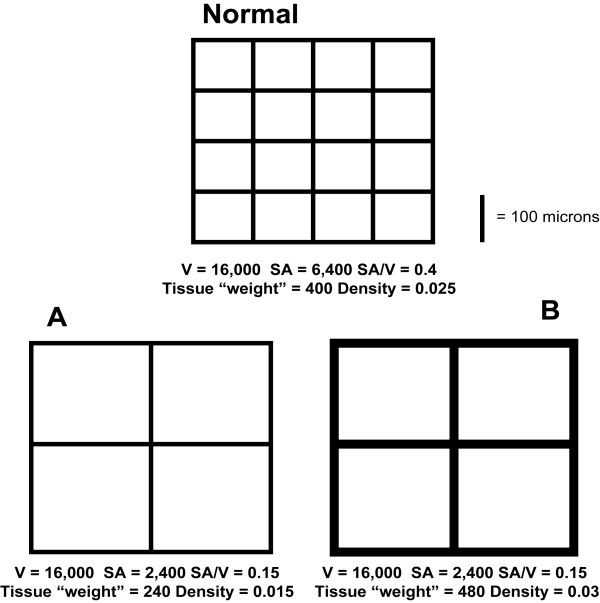
A Schematic Showing the Relationship between Lung SA/V and Density under two scenarios. The top panel represents normal lung architecture with the dimensions of each "alveolus" being 100 × 100 μm yielding a total volume of the "lung" = 16,000 μm3 with a surface area of 6,400 μm2 and a SA/V of 0.4. If we assign a mass of 10 units to each 100 μm length of "alveolar wall" this "lung" has a mass of 400 units and a density of 0.025 units/μm3 (= 400 units/16,000 μm3). In A, the volume and thickness of the "alveolar walls" remains the same as those in "normal lung architecture" but the surface area is decreased due to destruction of "alveolar walls". In this scenario, the reduction in SA/V and density are proportional. However in scenario B, the thickness of the "alveolar walls" is doubled therefore increasing the mass. The resultant SA/V is the same as in A whereas the density is higher than in A and even higher than the Normal. Thus if there is addition of tissue, the relationship between SA/V and density is disrupted.